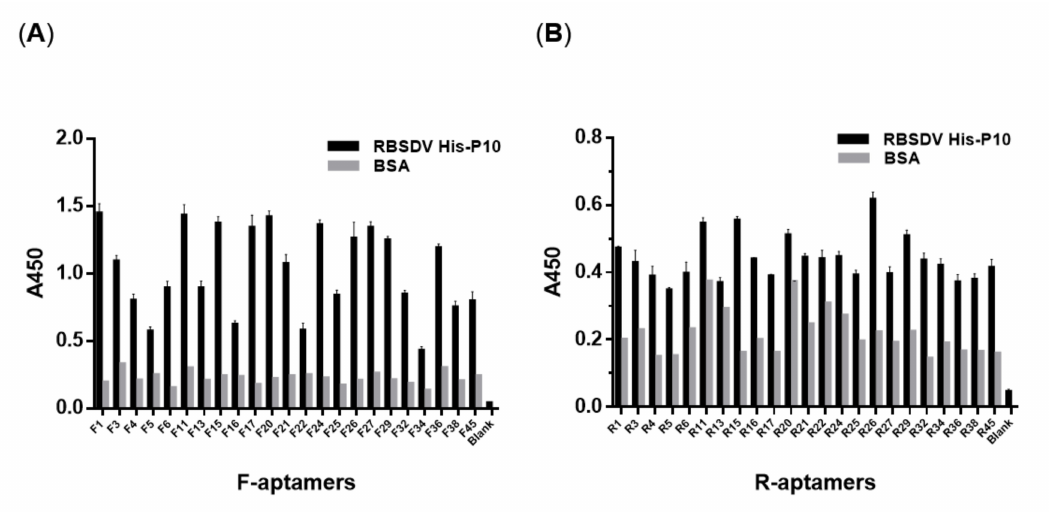
Figure 6. Detection of the RBSDV His-P10 protein using 23 selected F-aptamers and 23 selected R-aptamers by enzyme-linked oligonucleotide assay (ELONA). Each F-aptamer ( A ) or R-aptamer ( B ) was used at 100 µ L (1 µ g / mL) to detect 200 ng RBSDV His-P10 protein-coated wells using Costa EIA